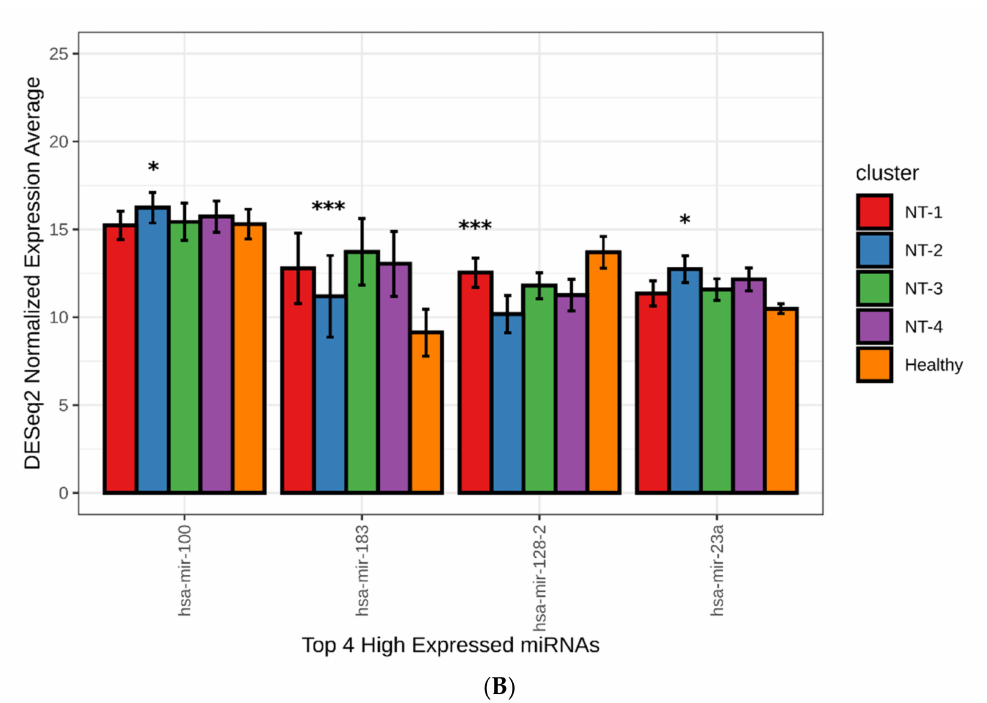
Figure 6. ( A ). Number of differentially highly or lowly expressed miRNAs identified in NT-1-4 gliomas. The differential analysis was performed using DESeq2 R packages without taking into account healthy samples ( n = 5). High or low expression of miRNAs in an NT cluster indicates the miRNAs having the highest/lowest expression in one of the four NT clusters. ( B ) Average expression levels for hsa-mir-100, hsa-mir-183, hsa-mir-128 and hsa-mir-23a in NT-1-4 gliomas. Stars represent the significance of the glioma cluster compared to the others (healthy samples are excluded in the comparison: * p < 0.05; *** p <